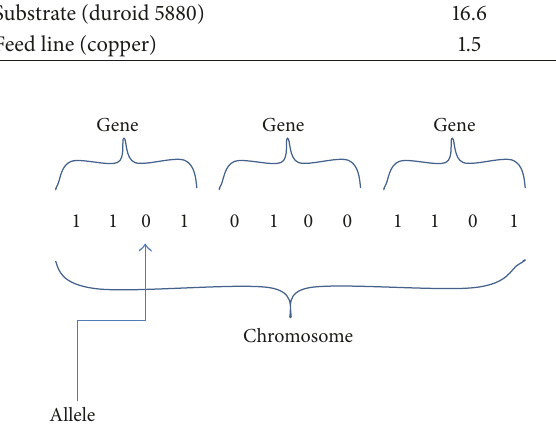
Figure 4: Sample of a binary